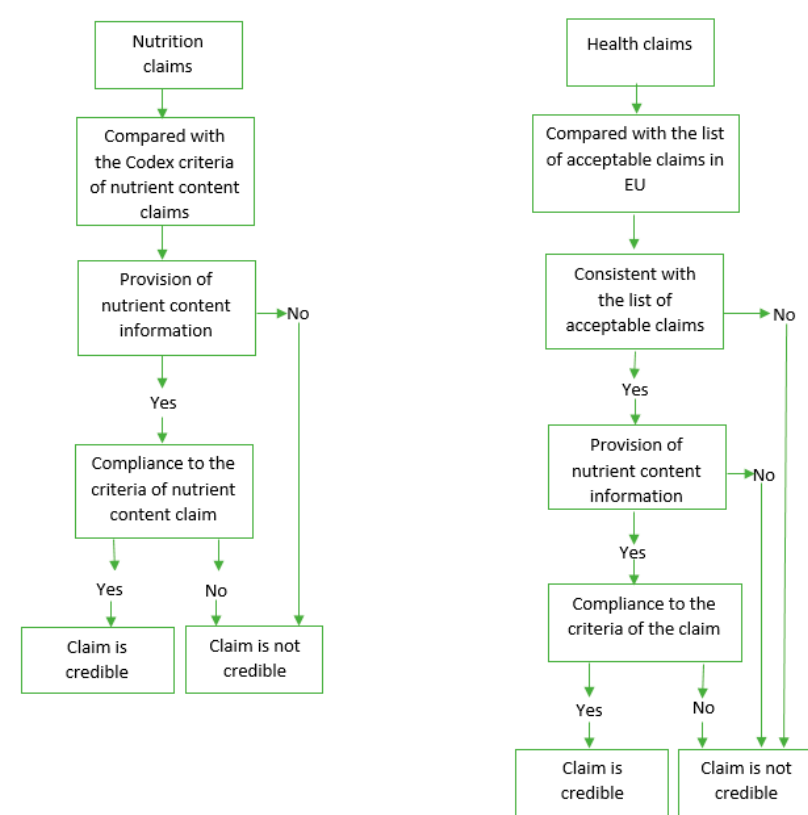
Figure 1. Assessment of credibility of nutrition and health claims.